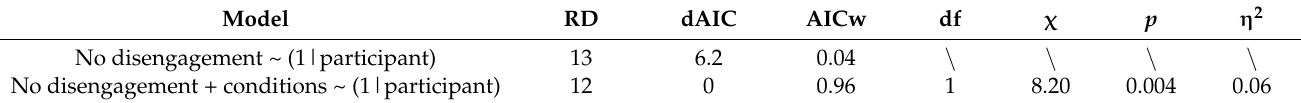
Table 2. Model comparison for predicting the number of trials with no disengagement in the overlap task.